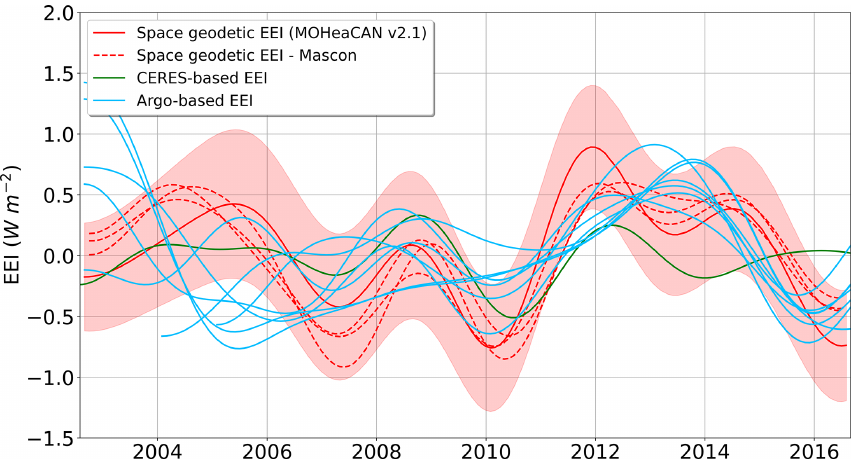
Figure 7. Interannual variations in Earth energy imbalance (EEI) time series. Mean and trend values have been removed for each time series, and a filter has been applied to remove signals lower than 3 years. Red lines correspond to space geodetic estimates where estimates based on mascon ocean mass are represented as dashed lines, and MOHeaCAN v2.1 is represented by the mean value (solid red) and the uncertainty at 1-sigma (shaded areas). The green line corresponds to CERES-based estimates and blue lines to the Argo-based